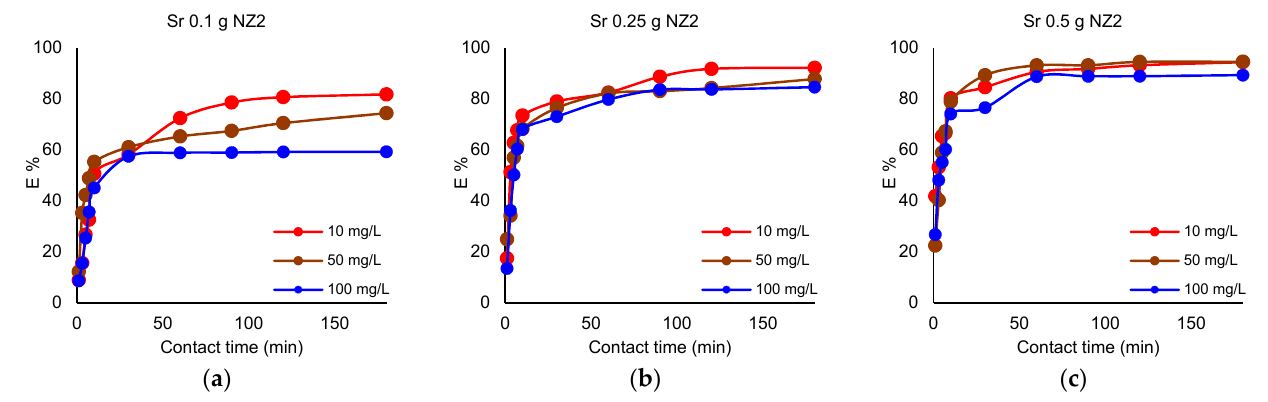
Figure 4. Removal e ffi ciency (%) of Sr 2+ by di ff erent NZ2 quantities; ( a ) 0.1 g, ( b ) 0.25 g, ( c ) 0.5 g; V Figure 4. Removal efficiency (%) of Sr 2+ by different NZ2 quantities; ( a ) 0.1 g, ( b ) 0.25 g, ( c ) 0.5 g; = 50 mL; 200 rpm; 22 ± 2 °C, 180 min. V = 50 mL; 200 rpm; 22 ± 2 ◦ C, 180